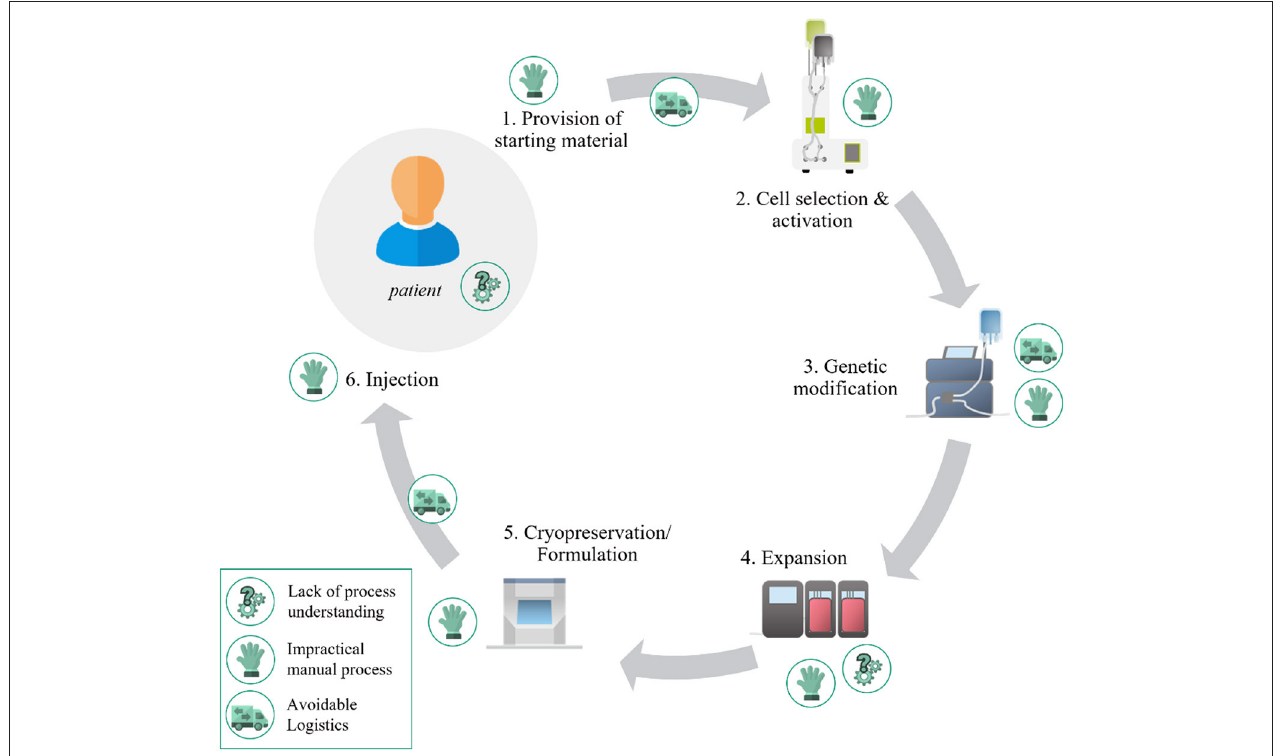
FIGURE 1 | Challenges for wide-scale deployment of autologous CAR-T cell